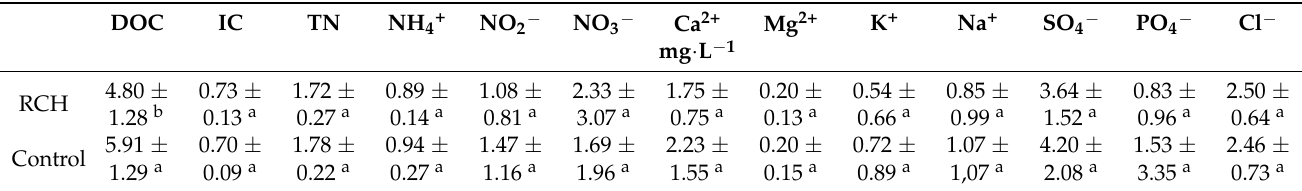
Table 6. Properties of leachate from charcoal hearth horizon (RCH) and control soil (experiment 2).